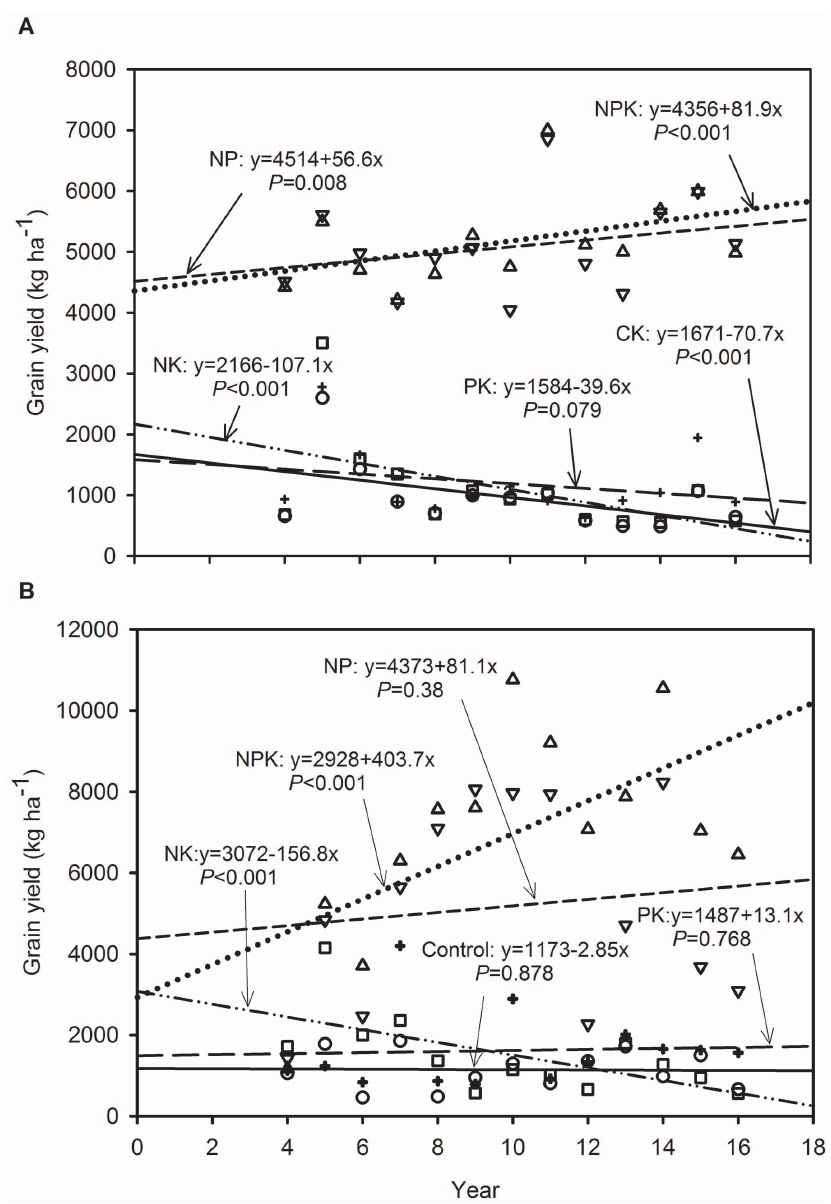
Figure 1. Grain yield of wheat (a) and maize (b) of different fertilizer treatments (Control, circle; NPK, triangle up; NP, triangle down; NK, square; PK, plus) under wheat-maize rotation system from 1994 to 2006 at Yucheng, Shandong Province of China.